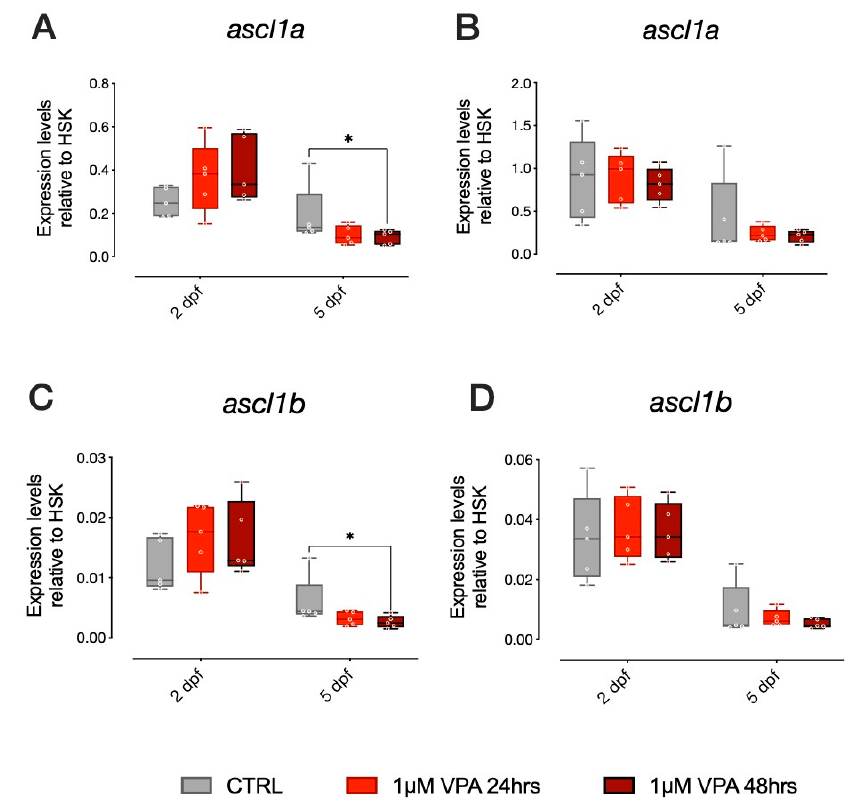
Figure 2. mRNA expression of ascl1a and ascl1b in 2 dpf and 5 dpf AB and TU zebrafish after 24 or 48 h of 1 µM VPA. Changes in the expression of ascl1a ( A , B ) and ascl1b ( C , D ) in AB ( A , C ) and TU ( B , D ) zebrafish embryos. Box plot (median, min to max) of mean dCt values for each group. **** p < 0.0001, *** p < 0.001, ** p < 0.01, * p < 0.05.